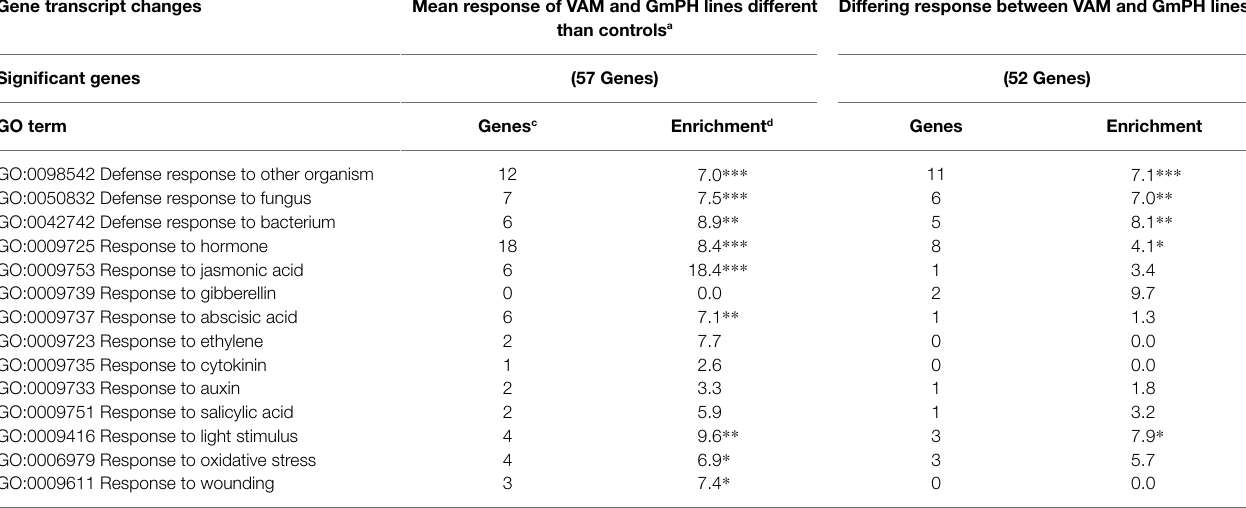
TABLE 5 | Enrichment of GO terms among genes significantly altered in transcript levels in GmPH and VAM lines in the presence of Phytophthora sojae . Gene transcript changes Mean response of VAM and GmPH lines different than controls